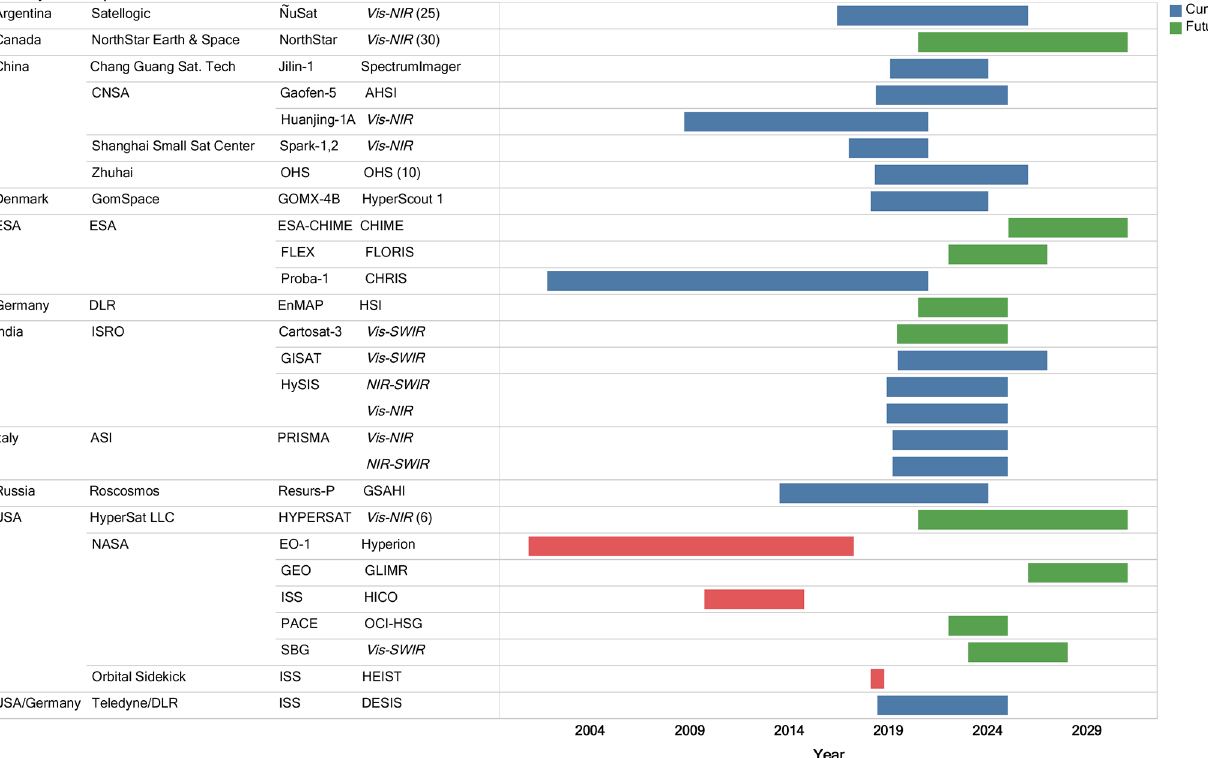
Figure 1. The chart depicts the timeline of historic, existing, and planned high spectral resolution remote sensing missions by country or agency, operator, platform, and sensor name or type (general sensor type is conveyed in italics). Note that where there is a constellation or multiple sensors for the mission, the number of sensors is given in parentheses at the end of the sensor